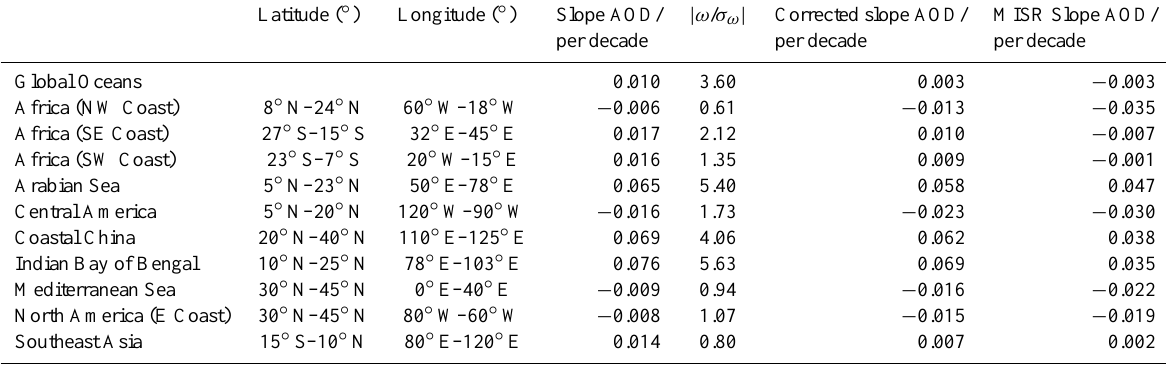
Table 1. Ten-year AOD trend analysis for the selected target regions. The deseasonalized DA quality over-water Terra MODIS aerosol products from March 2000 to December 2009 were used. The correct slope refers to the slope of the AOD trend analysis after the 1 AOD correction. Trend analysis for global oceans is also included. Note that regions with | ω / σ ω | > 2 are consider to have real trends with a 95% confident level. The last column shows the ten-year AOD trend analysis using the deseasonalized MISR aerosol product. Latitude ( ◦